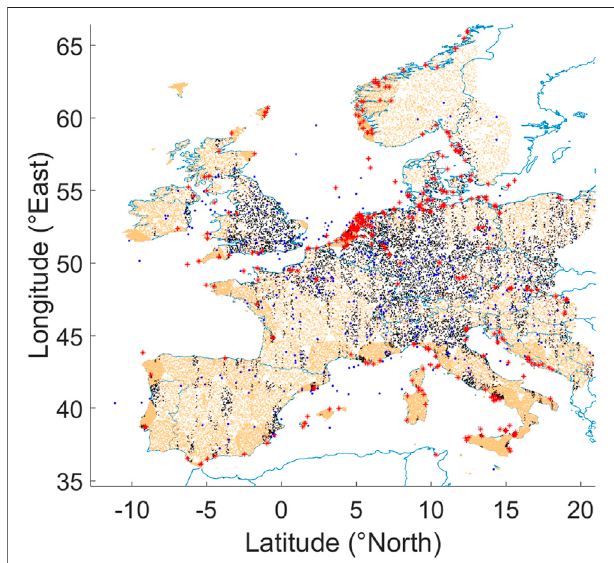
FIGURE 5 | Snapshot of the generated terminals (red (cid:1) boat, blue (cid:1) plane, other (cid:1)